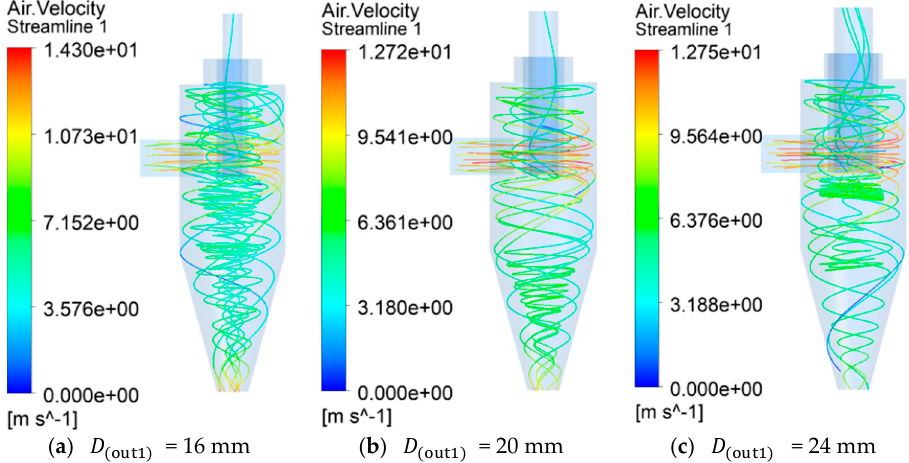
Figure 6. Distribution of bubble motion in longitudinal section.